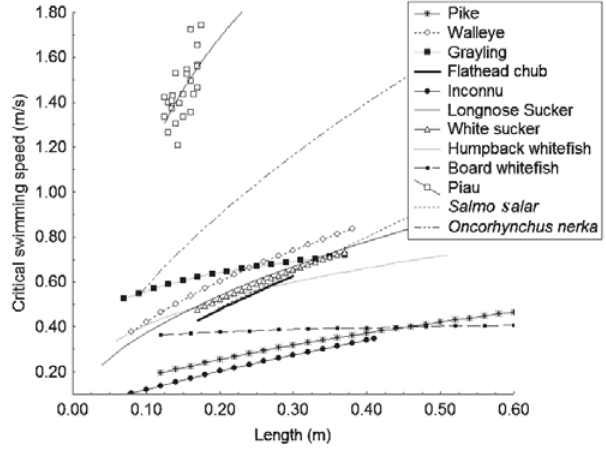
Fig. 5. Curves representing the relationship between critical speed (m/s) and length (m) for the piau at different tempera- tures, compared to two salmonids ( Salmo salar and Oncorhynchus nerka ).